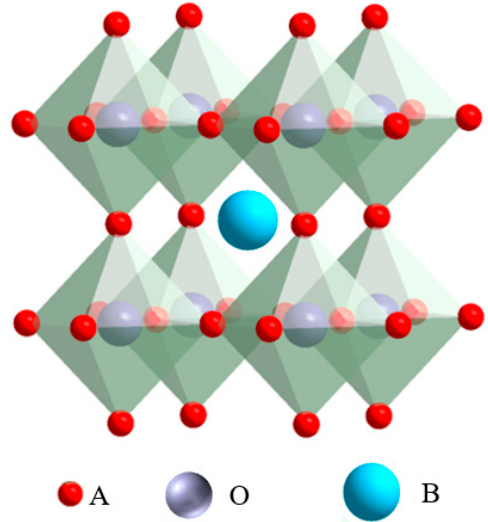
Figure 1. A schematic of the ideal ABO 3 perovskite unit cell. There are defects in perovskite oxide crystals like most crystals. According to the electric neutral principle, ABO 3 can be composed of three kinds: A +1 B +5 O 3 , A +2 B +4 O 3 , A +3 B +3 O 3 . In the perovskite structure, the larger radius of the A ion can be partially or completely lost, so A-site ion defects are common. The B-site ions have a relatively large charge and small ionic radius. From a thermodynamic point of view, the B-site is unfavorable. There are several ways to generate ionic